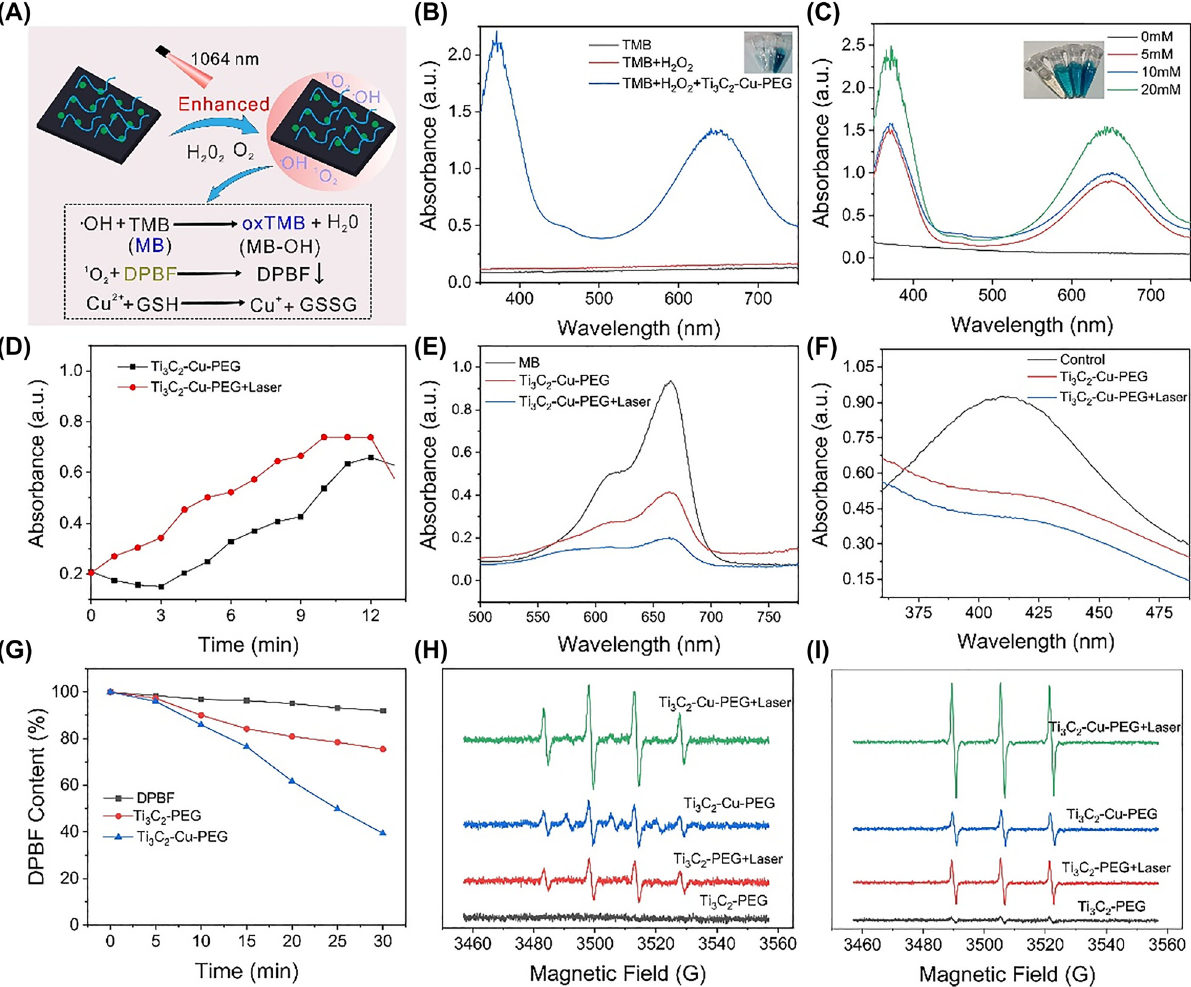
C -Cu-PEG. (B) UV–vis absorption 3 2 C -Cu-PEG with different H O concentrations. The insets are the 3 2 2 2 C -Cu-PEG with or 3 2 C -Cu-PEG with or without laser 3 2 generation of Ti C -PEG and Ti C -Cu-PEG under laser irradiation. (H) ESR spectra of · OH trapped 2 3 2 3 2 C -PEG and Ti C -Cu-PEG with or without laser irradiation 3 2 3 2